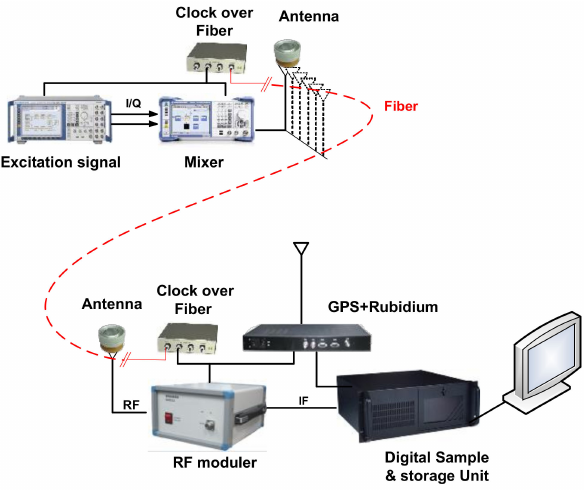
Figure 2. The measurement system setup.